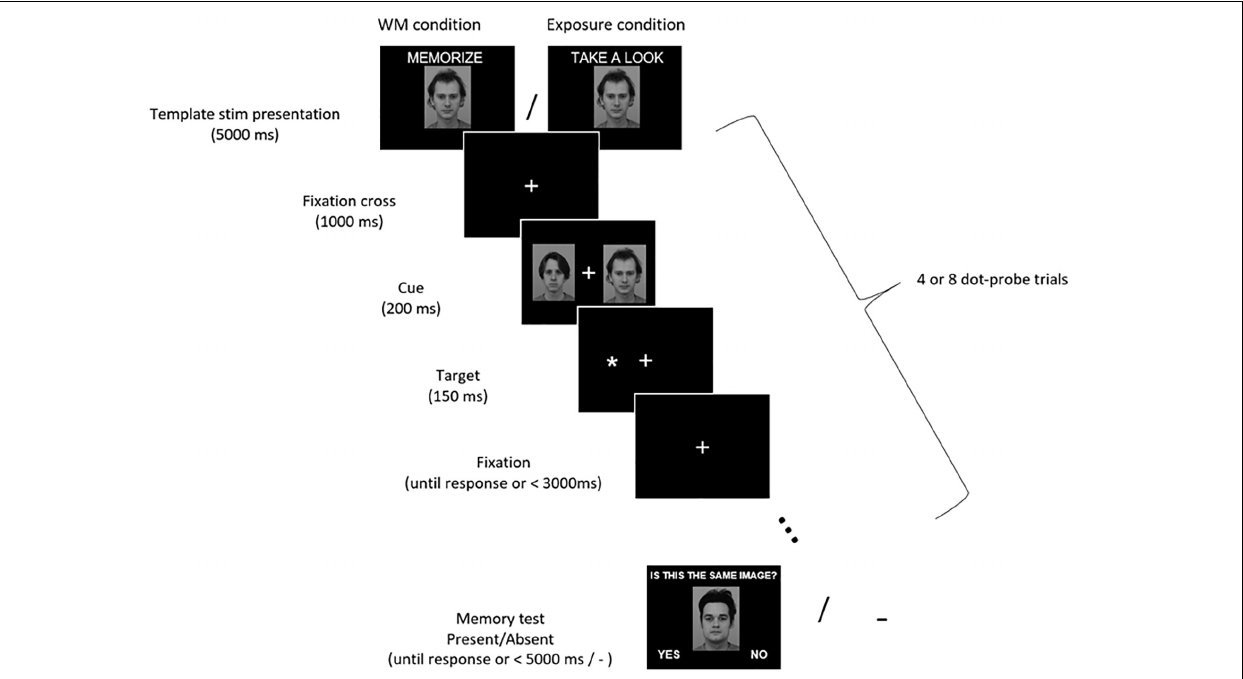
FIGURE 1 | Experimental procedure. Participants were asked to memorize (WM condition) or just look (exposure condition) at the presented stimulus (either a face or a house). Then they performed 4 or 8 dot-probe trials in which their task was to indicate with a button press the location of a target asterisk (left or right). Asterisks were preceded by pairs of stimuli, which participants were supposed to ignore. A memorized/seen stimulus was presented on one side, and a control one on the other side. In the WM condition participants completed a memory test, in which they had to decide if the presented stimulus is the one they were instructed to memorize (in the exposure condition there was no memory test). Images from KDEF stimulus set reproduced with permission from Lundqvist et al. (1998). IDs of images included in the Figure: AM13NES and